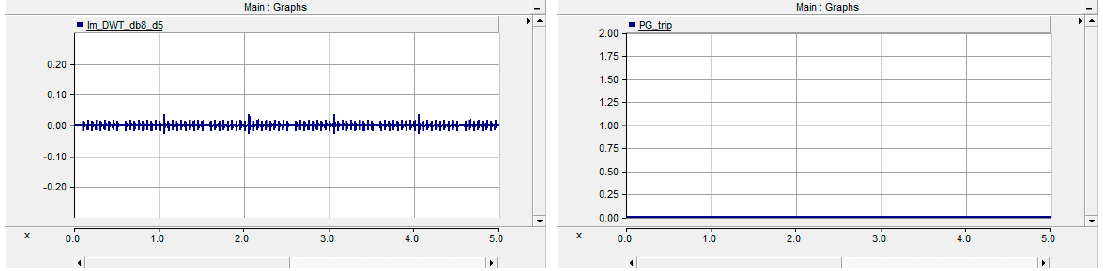
Figure 10. The simulation result under pole to pole (PtoP).